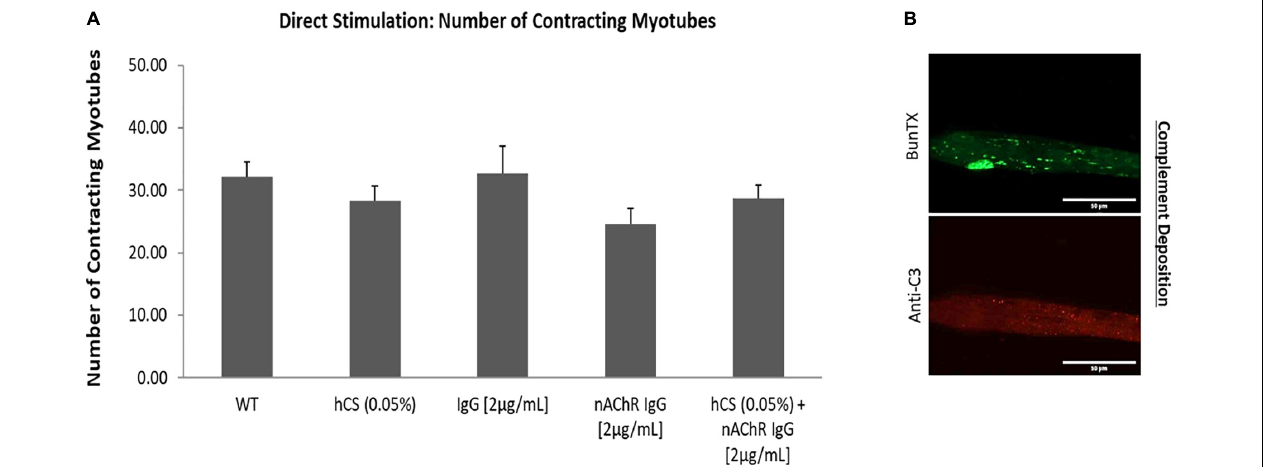
FIGURE 5 | Direct effects of hCS and anti-nAChR on SKM. (A) Demonstrates the number of contracting myotubes under direct stimulation after dosing with 0.05% hCS ( N = 2, 8 replicates), non-specific IgG (2 µ g/mL, N = 3, 8 replicates), anti-nAChR-Ab (2 µ g/mL, N = 2, 10 replicates) and a combination of 0.05% hCS and 2 µ g/mL anti-nAChR-Ab ( N = 2, 9 replicates). (B) ICC images of SKM incubated with 2 µ g/mL of anti-nAChR with 0.05% hCS for 3 h and stained with anti-C3 (red channel) and BunTX (green channel). Scale bars = 50